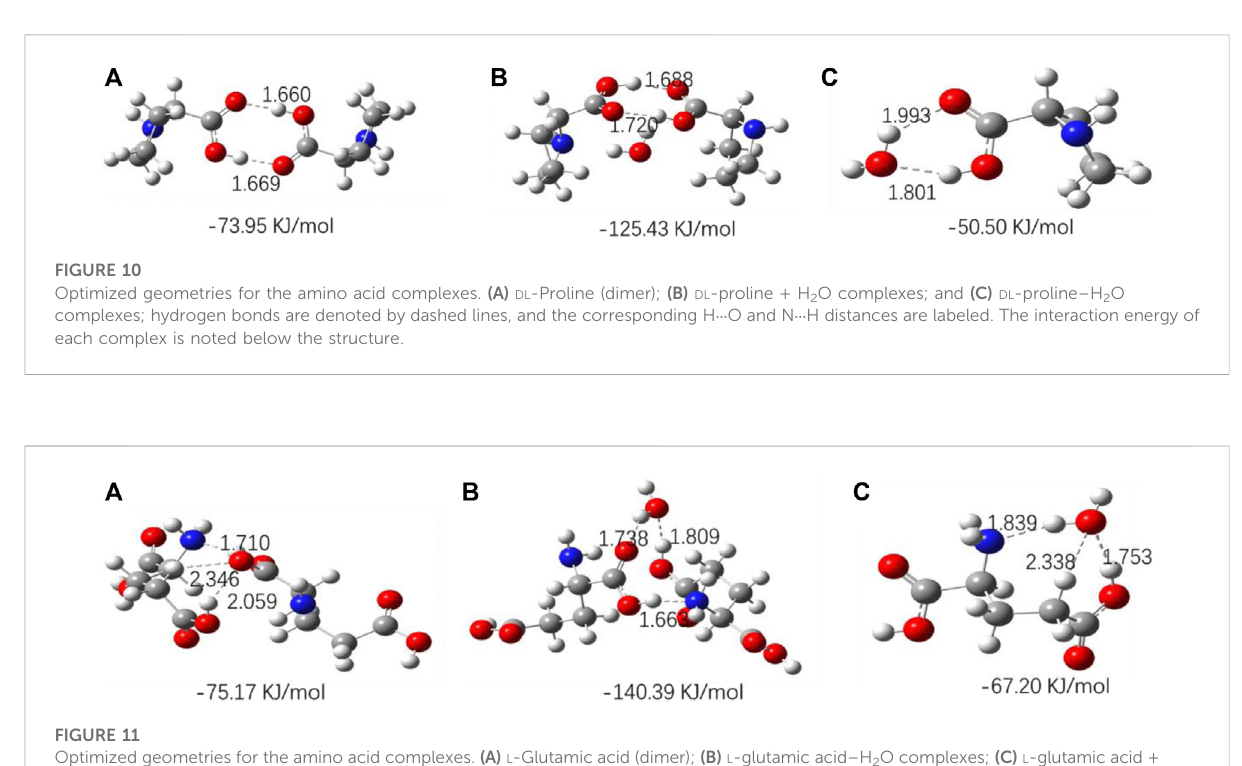
three amino acid aqueous solutions, dY = 0.27 kPa and the average of dP = 0.43%. dY and dP are calculated as follows: where N is the number of data points, P exp represents the